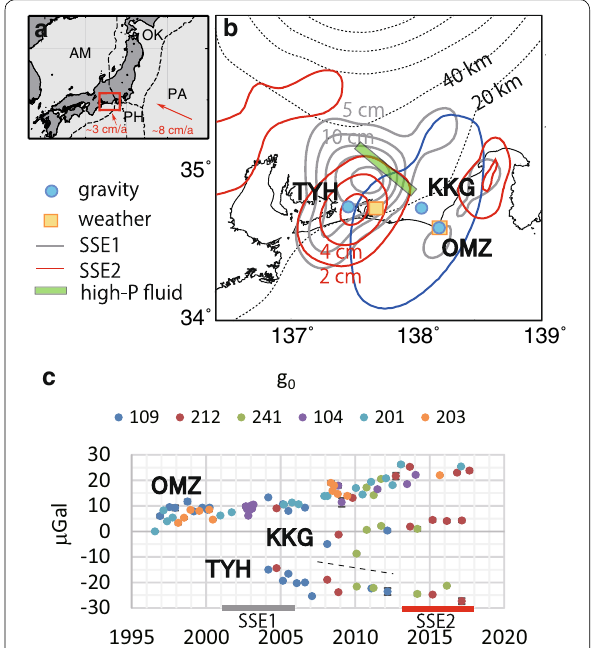
Fig. 1 The gravity observation sites and the raw data. a The study area. b The locations of the gravity observation sites. OMZ denotes the crustal deformation monitoring station of the GSI, and KKG and TYH are those of Nagoya University. The gray and red contours repre- sent the long-term slow slips which occurred during 2001–2006 and 2013–2017, respectively [Ozawa et al. 2016; the Geospatial Informa- tion Authority of Japan (GSI) (2017)]. The blue circle denotes the asperity of the anticipated great earthquake. Along the thick green line, the presence of high-pressure fluids is suggested (Kato et al. 2010). c The observed gravity changes (g 0 ) obtained after standard corrections of tides, polar motion and the barometric effect. The verti- cal axes denote relative gravity change in μGal and offsets are added for visualization. The different colors denote different S/Ns of the instruments. The error bars denote measurement errors (1 σ